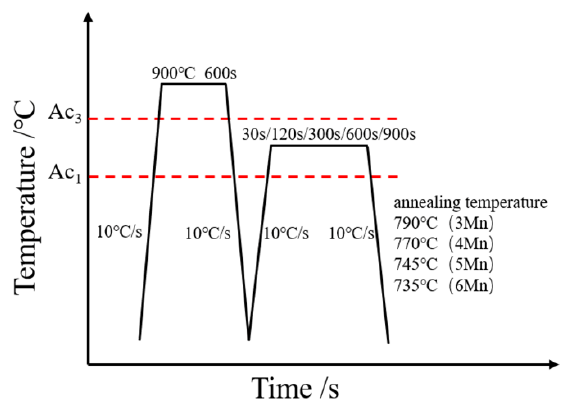
Figure 1. The final heat treatment process for the medium manganese steel samples. (Ac1 and Ac3 represents the initial and final temperature of austenite transformation during heating, respectively).